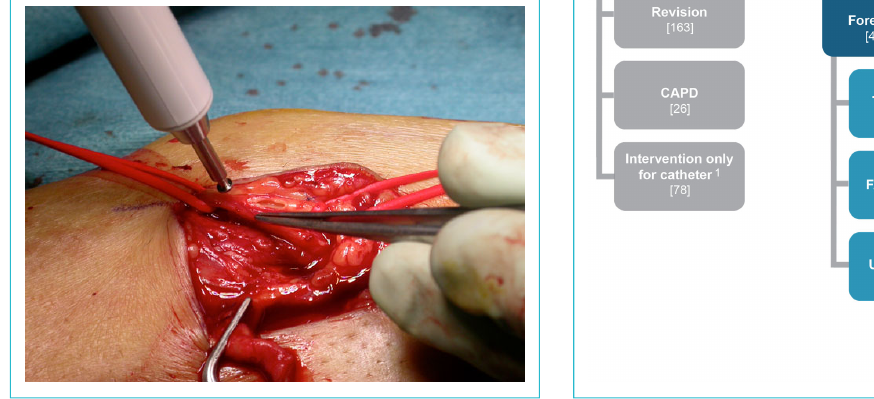
Figure 1: Vascular access creation (brachiocephalic arteriovenous fistula) using a punch.